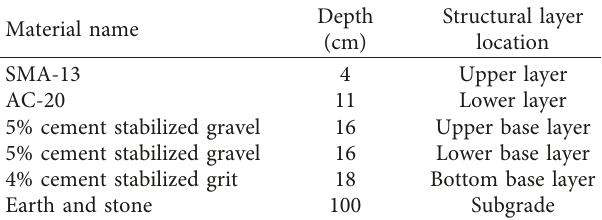
Table 1: Pavement structural